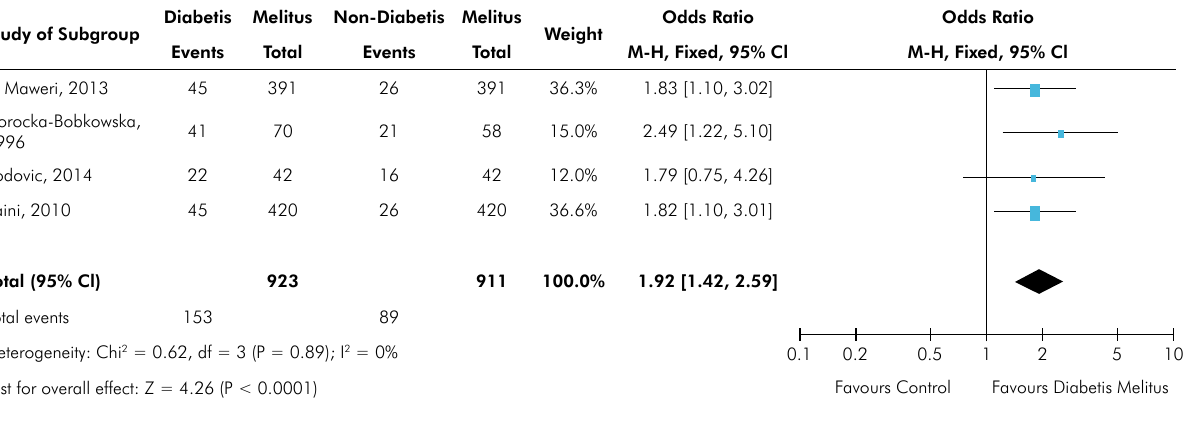
Figure 3. Forest plot of the association between denture stomatitis and diabetes